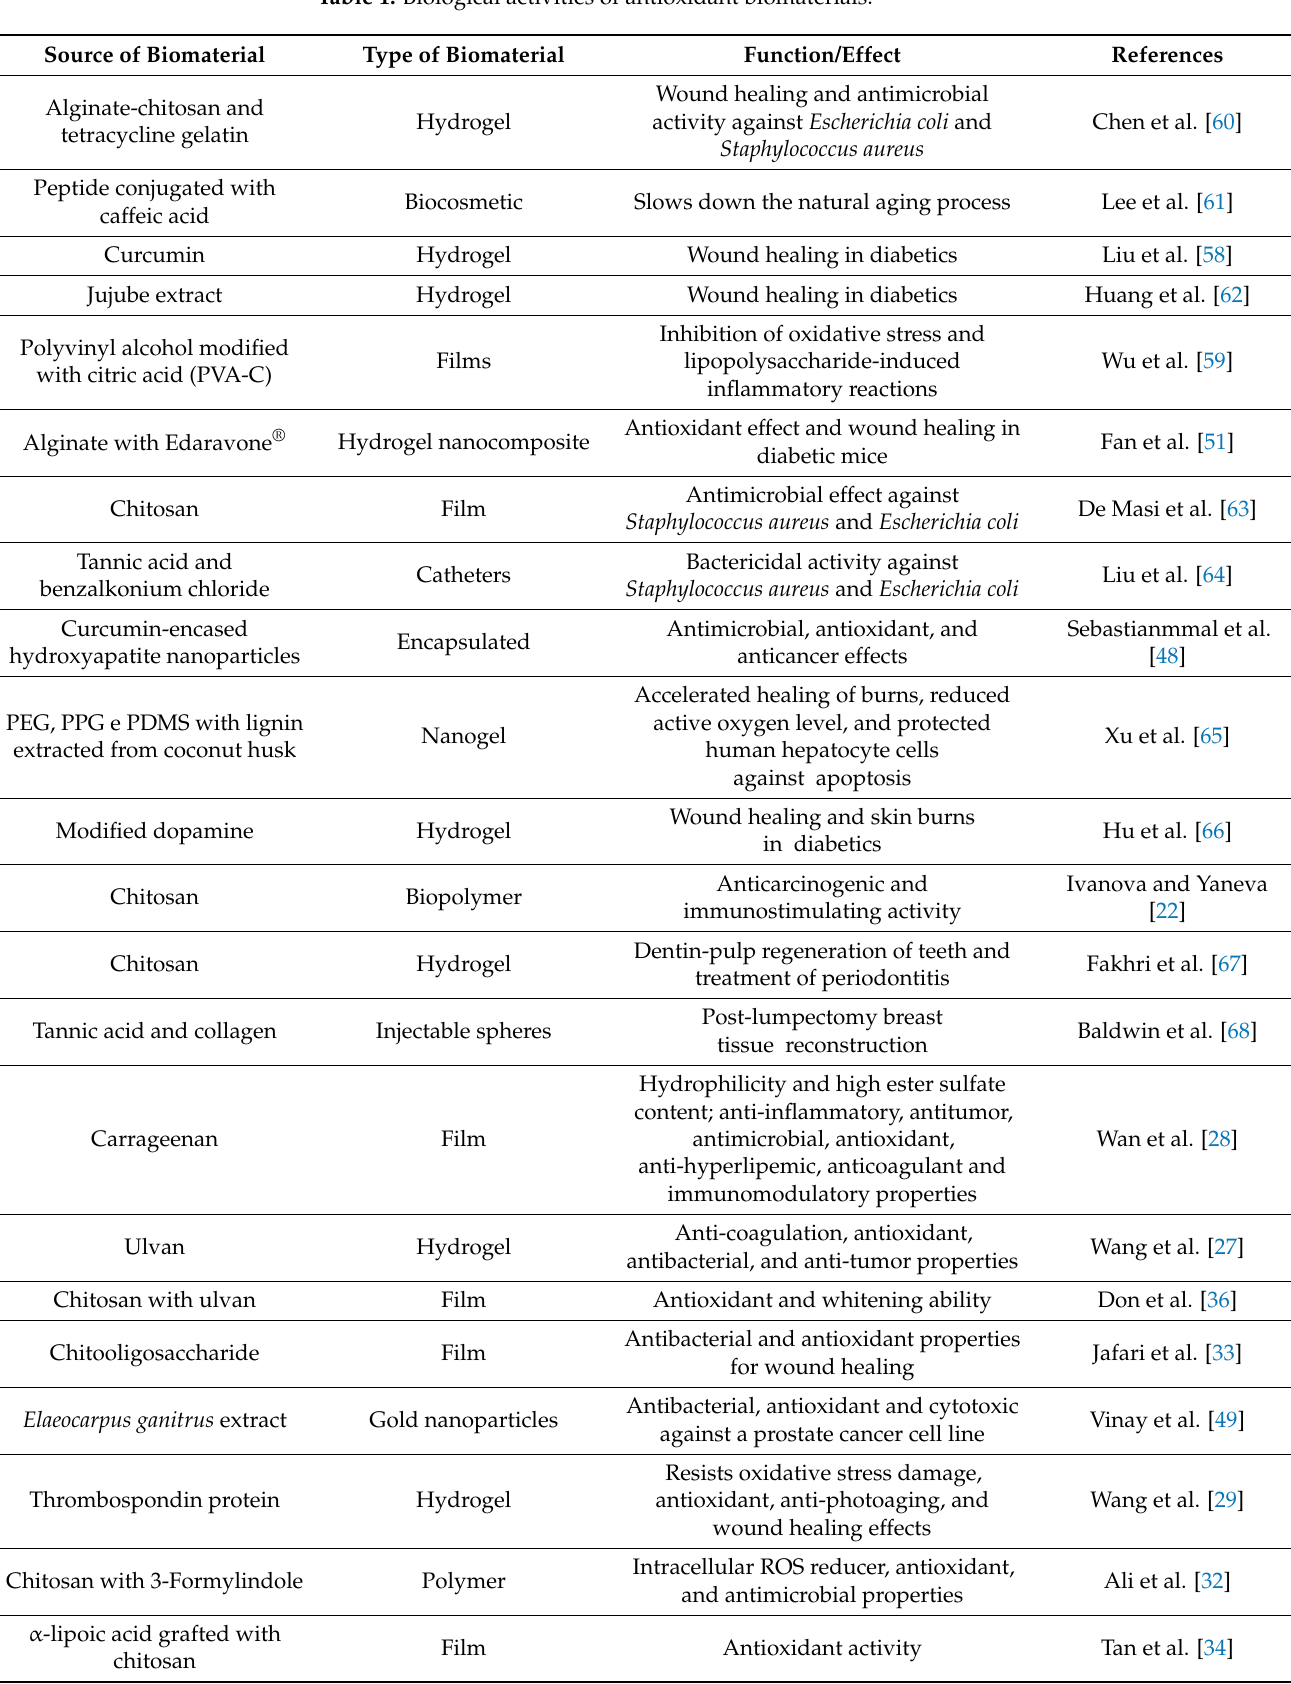
Table 1. Biological activities of antioxidant